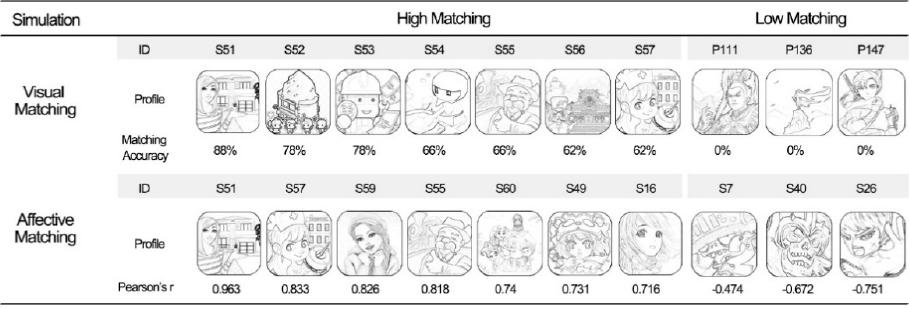
Figure 9. Simulation game icons with high perceptual